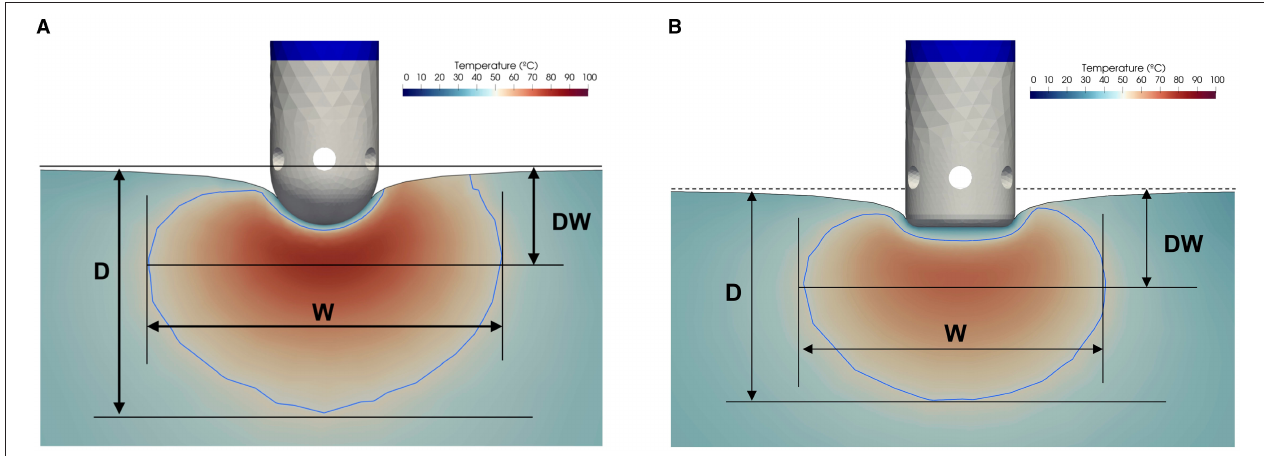
FIGURE 1 | Virtual lesion created with the two considered catheters. (A) Spherical tip and (B) Cylindrical tip. The area of irreversible tissue lesion (tissue temperature ≥ 50 ◦ C) is delimited by the blue line. Measurements: maximum depth (D), depth at the maximum diameter (DW), maximum diameter (W).